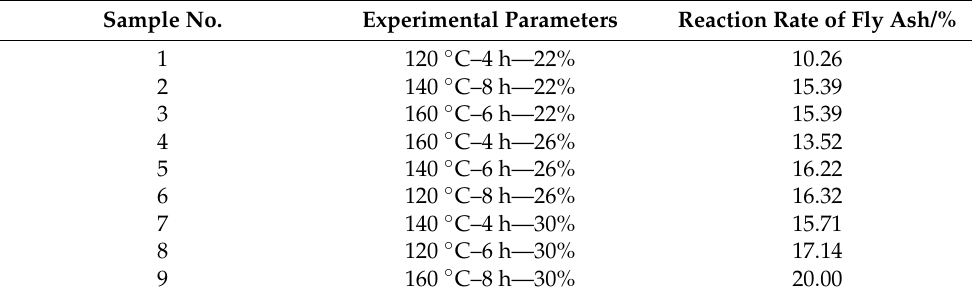
Table 4. Fly ash reaction degrees of different autoclaved samples. Sample